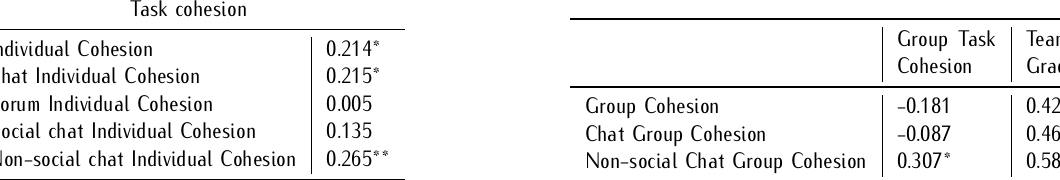
Table 7. Correlations between Group Cohesion, Chat Group Cohesion, Work-Chat Group Cohesion, Group Task Cohesion